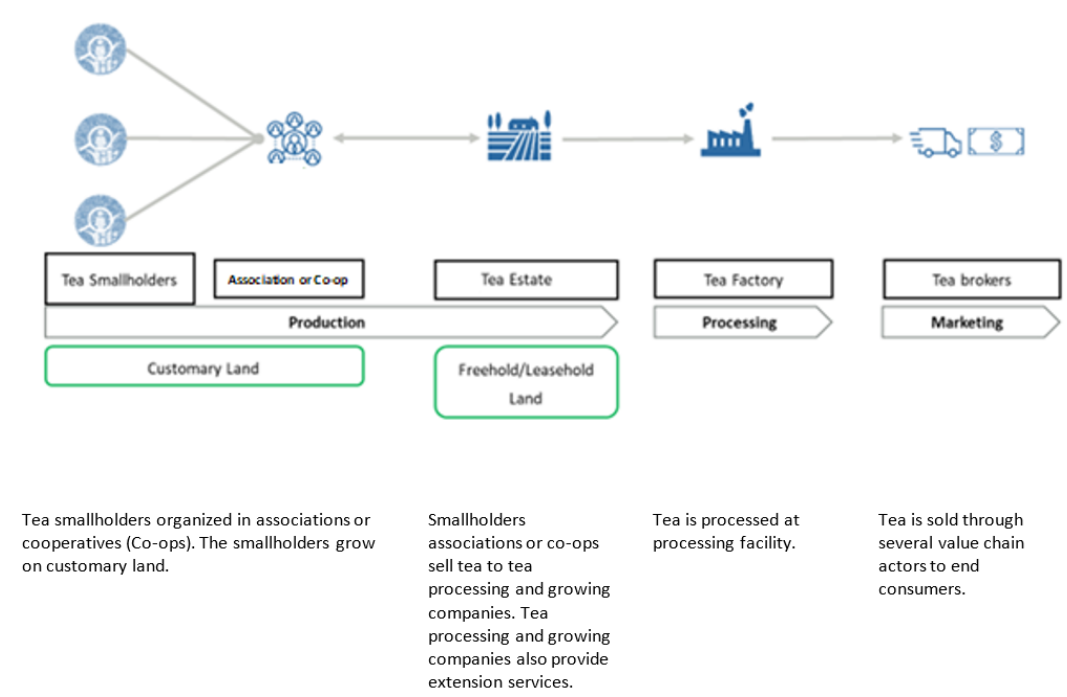
Figure 3. Overview of tea outgrower scheme in Southern Malawi.